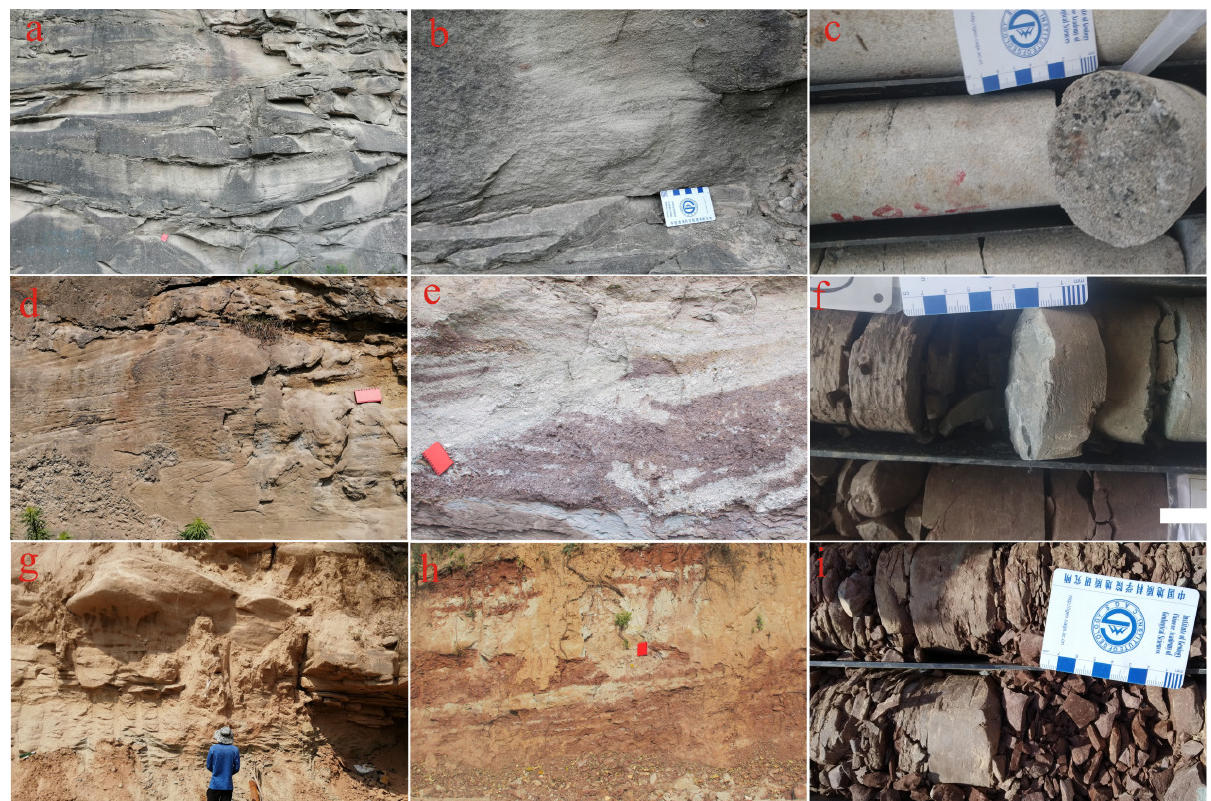
Figure 3. Sedimentary structures and lithologic characteristics of Zhiluo Formation. ( a ) Braided river channel sand bodies and its lateral distribution, Zhiluotown section, Fuxian. ( b ) Gray, grayish-green medium-coarse-grained sandstone with medium–large massive and trough crossbeddings, Zaoshugou section, Yongshou. ( c ) Trunk fossils and carbonized plant debris in sandstone, from well SD01 at 1933.3 m. ( d ) Trough and tabular cross beddings, Zhiluotown section. ( e ) Gravel, gravel-bearing coarse sandstone, obvious channel scouring surface, Yongshou section. ( f ) Grayish-green, purple fine sandstone and siltstone with small-scale inclined and horizontal bedding, from well SD01 at 1829 m. ( g ) Earth-yellow medium-fine sandstone with large-scale trough cross bedding, obvious scouring phenomena, Zhiluotown section. ( h ) Interbedding of purple, purplish red, grayish-green mudstone and siltstone, Linyou section. ( i ) Purplish-red, brownish-red, and grayish-yellow mudstone and siltstone with medium–thin gray and purplish-red fine sandstone sandwiched in the middle, from well SD01 at 1669 m.